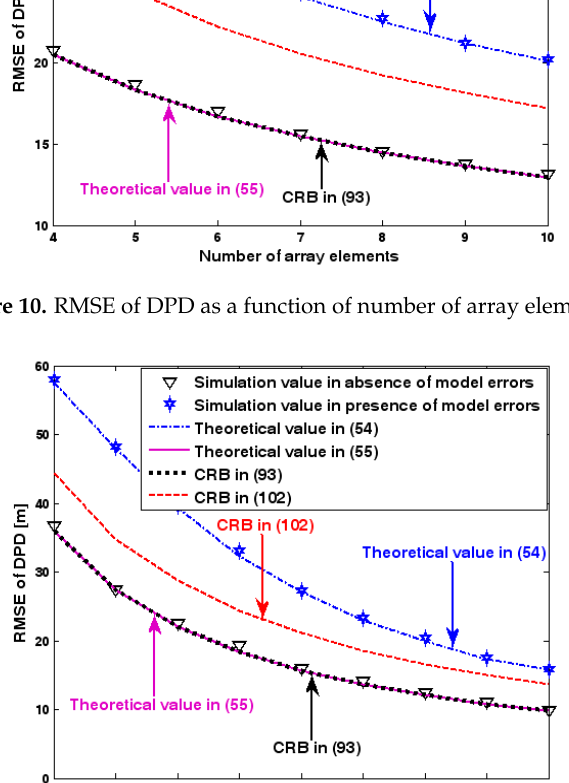
Figure 11. RMSE of DPD as a function of ratio of array radius to wavelength.